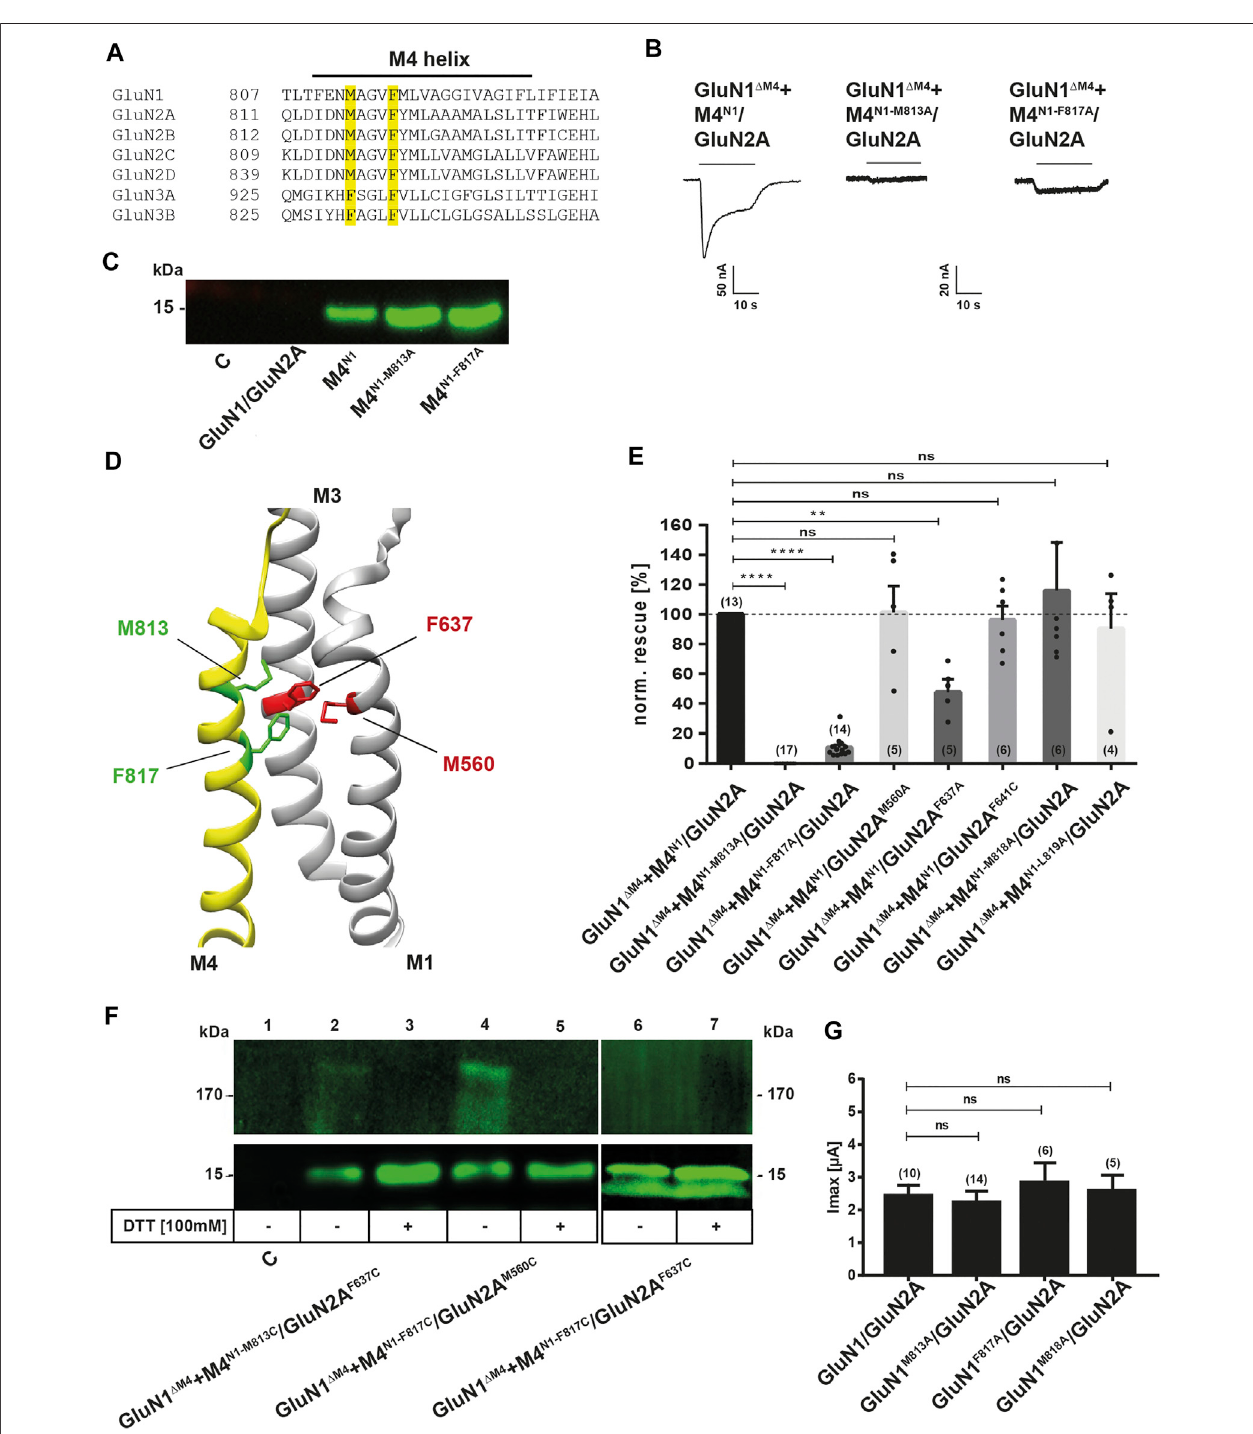
FIGURE 3 | Examination of the possible interaction residues of GluN1-M4 and GluN2A-M1/M3. (A) Sequence alignment of the human GluN1, GluN2 and GluN3 M4 segments. Sequences were taken from Uniprot and sequence alignment was performed using the Multiple Sequence Alignment Tool from EMBL-EBI. The residues identi fi edaspossibleattachmentsites,M813andF817,arehighlightedinyellow. (B) RepresentativeTEVCimagesofGluN1 Δ M4 +M4 N1 /GluN2A,GluN1 Δ M4 +M4 N1-M813A / GluN2A, and GluN1 Δ M4 +M4 N1-F817A /GluN2A show the impaired rescue effect of the two point mutations. M4 N1-M813A resulted in a complete loss of rescue effect, whileM4 N1-F817A resultedina ∼ 90%decreaseinrescuedcurrent. (C) Westernblotofsurfaceproteinsisolatedbybiotinylation,withaprimaryantibodyagainsttheGluN1 CTD, showing that M4 N1 , M4 N1-M813A , and M4 N1-F817A are all well expressed at the cell surface, ruling out that impaired expression is responsible for the loss of the rescue effect. (D) Representation of GluN1-M4 (yellow) and GluN2A-M1/M3 (gray). Structural analysis was performed using UCSF Chimera with the